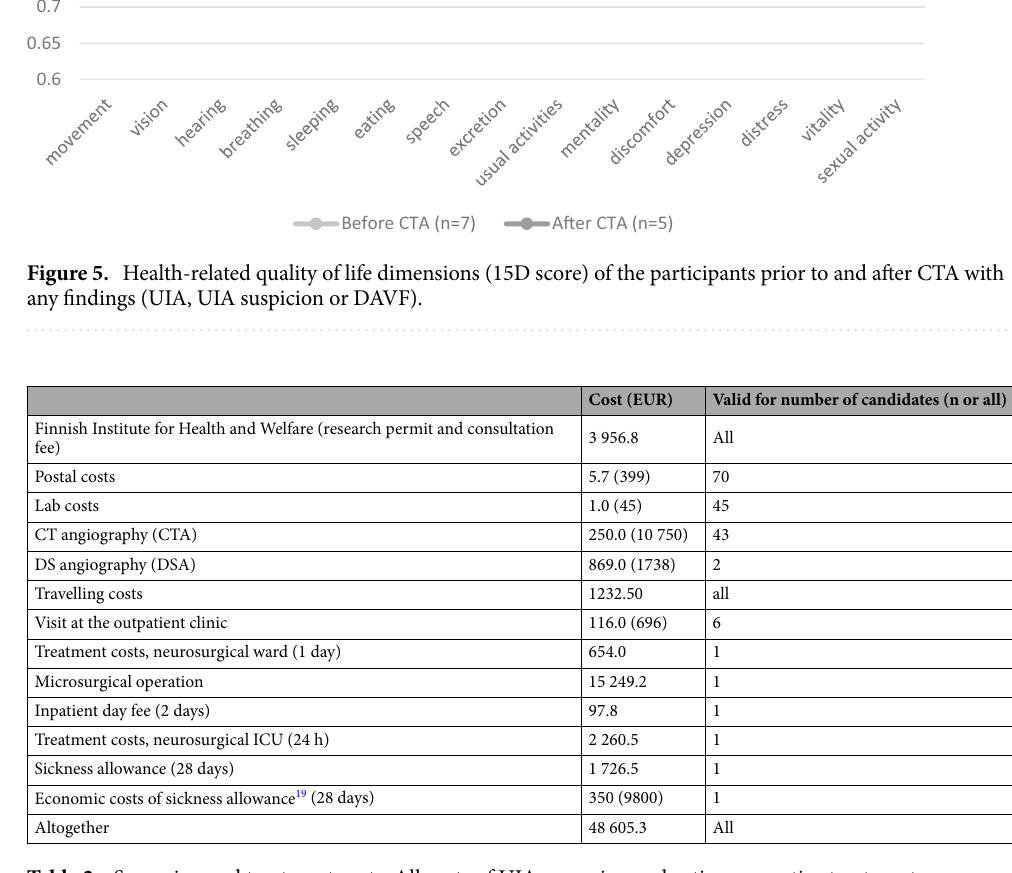
Table 2. Screening and treatment costs. All costs of UIA screening and active preventive treatment (microsurgical treatment) of one UIA patient. Economic costs have been estimated by using the evaluation of Confederation of Finnish Industries (EK) considering the costs of sickness absence 19 . CTA Computed Tomography Angiography, DSA Digital Subtraction Angiography or Catheter Angiography, ICU Intensive Care Unit.